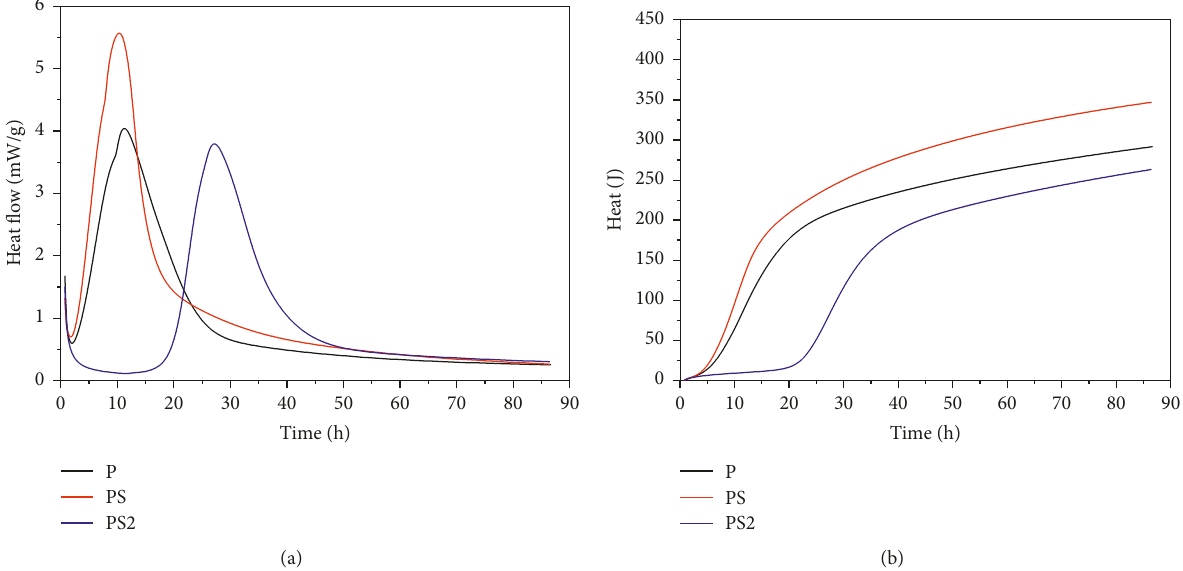
Figure 7: Isothermal calorimetry results of heat flow (a) and total hydration heat